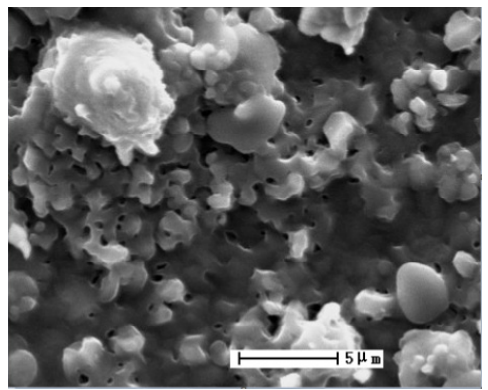
Figure 5. Surface morphology of Mg ‐ Al hard coating.